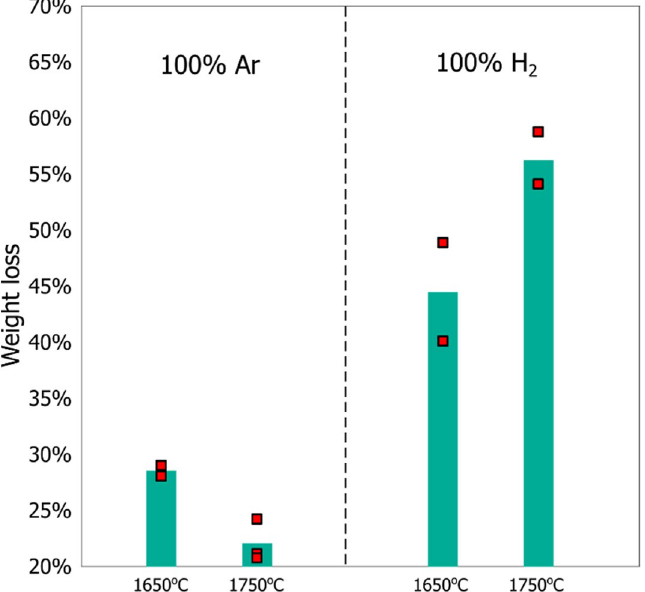
Figure 4. A comparison of the weight loss relative to starting weight of the raw material when using Ar and when using H 2 as the process gas. The weight loss includes the crucible weight change and the raw material weight loss.